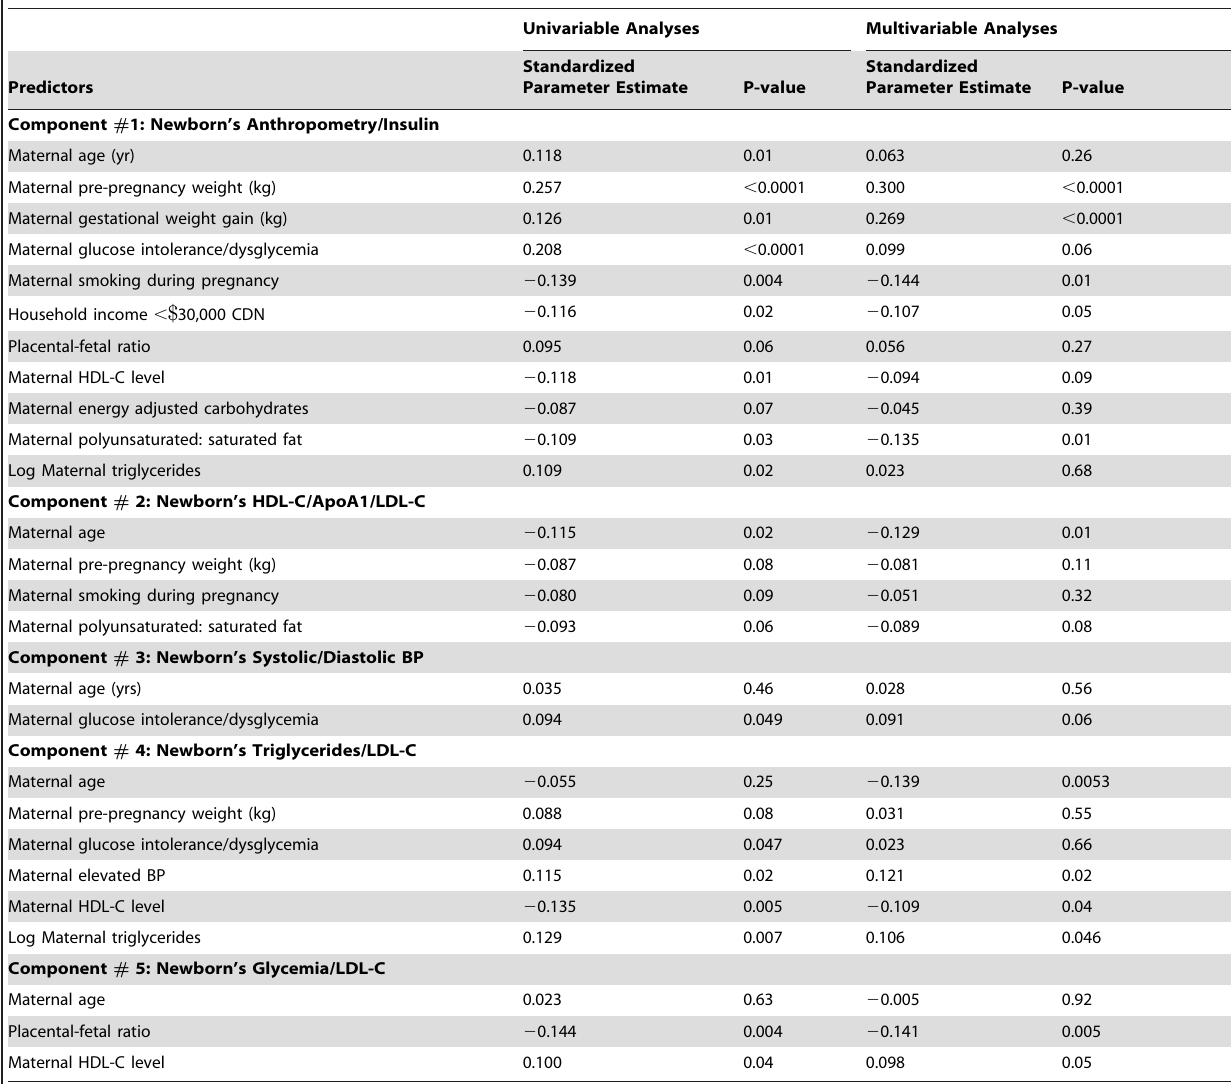
Table 8. Maternal variables as predictors of principal components (N